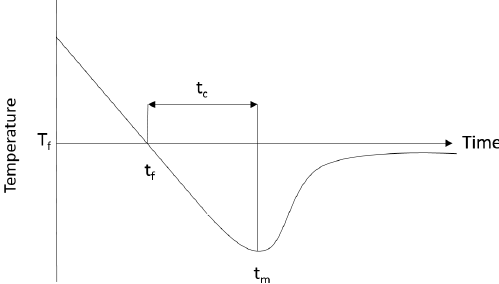
Figure 7. Typical water supercooling curve as a function of time, where t f is the time of freezing, t m is the time of minimum temper- ature, t c is the time of cooling and T f is the freezing temperature.